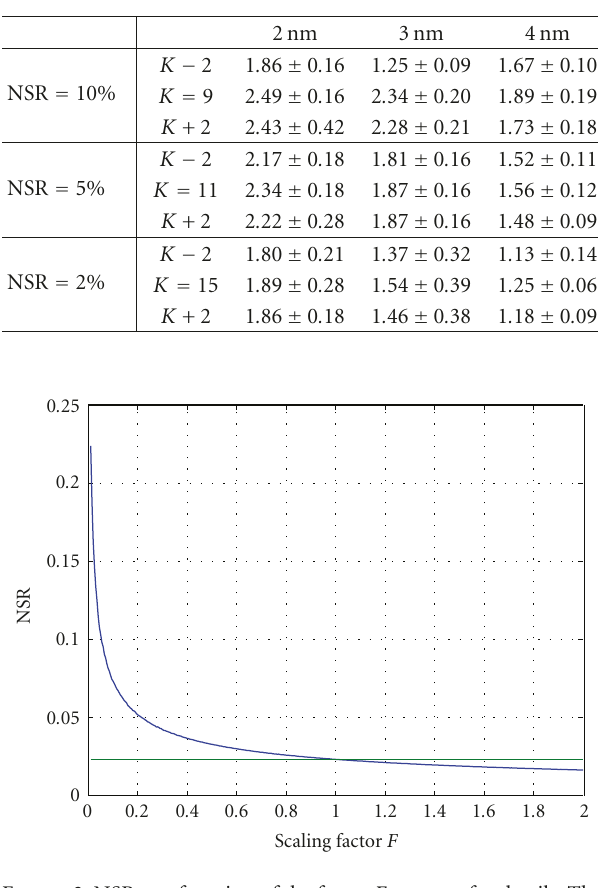
Table 2: Measure E (see (3)) of the filter performance as a function of the order K of the filter. The synthetic XRD intensity data refer to di ff erent sample sizes and NSRs. The best performance corresponds to the order K reported in the middle row of each NSR value.